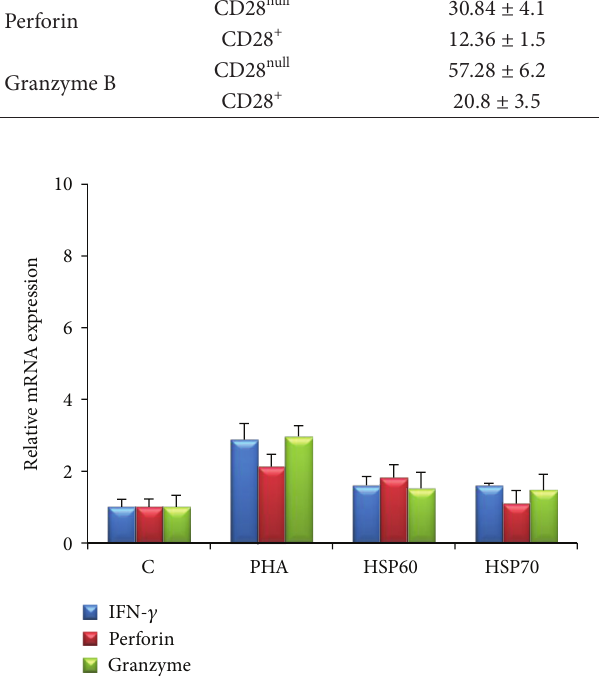
Figure 4: Relative mRNA expression of INF- 𝛾 , perforin, and granzyme B in CD4 + CD2 8 null cells in healthy subjects. No antigenic response was observed in cells stimulated with HSP60 (5ng/mL) and HSP70 (5ng/mL), whereas PHA (10 𝜇 g/mL) (positive control) showed increased expression of